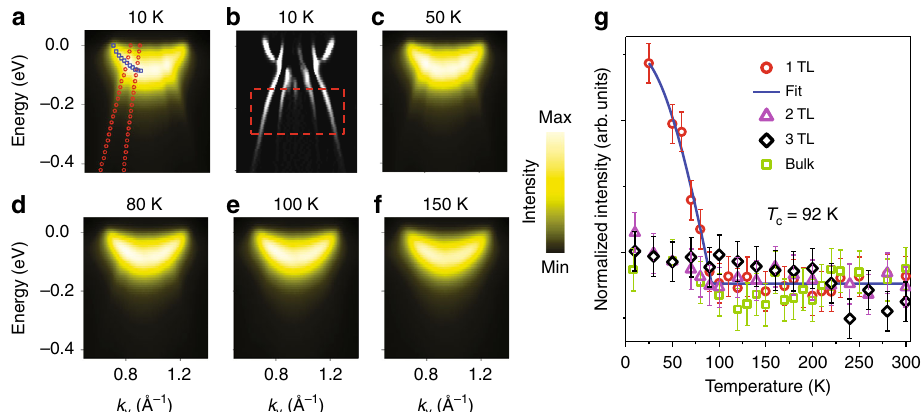
Fig. 2 Temperature dependence of the folded valence bands and the CDW transition temperature. a ARPES map around M at the zone boundary taken at 10 K. The red and blue curves indicate the (2 × 2) folded valence bands and the conduction band, respectively, on the left side only, assuming that the bands do not interact. b Second-derivative map of the same data, which highlights the band dispersions. The red dashed box indicates a region of interest used for integrating the ARPES intensity as a measure of the folded-band intensity. c – f ARPES maps taken at 50, 80, 100, and 150 K, respectively. The folded valence bands diminish as T increases. g Integrated ARPES intensities over the region of interest as a function of temperature for the 1-TL, 2-TL, and 3-TL and bulk TiTe 2 samples. The error bar is deduced from the s.d. of the fi tting. The blue curve is a fi t using a mean- fi eld equation described in the text